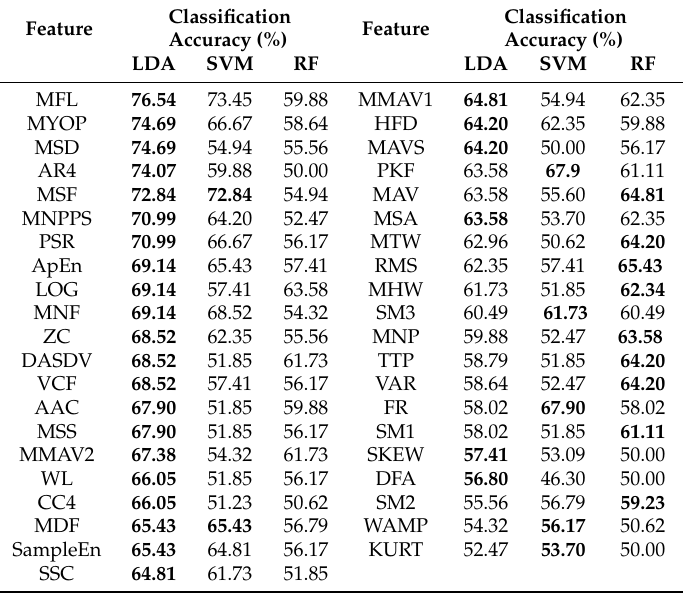
Table 4. Majority vote classification accuracies for individual features. Features are ordered by LDA classification accuracy. The best classifier result for each feature is in